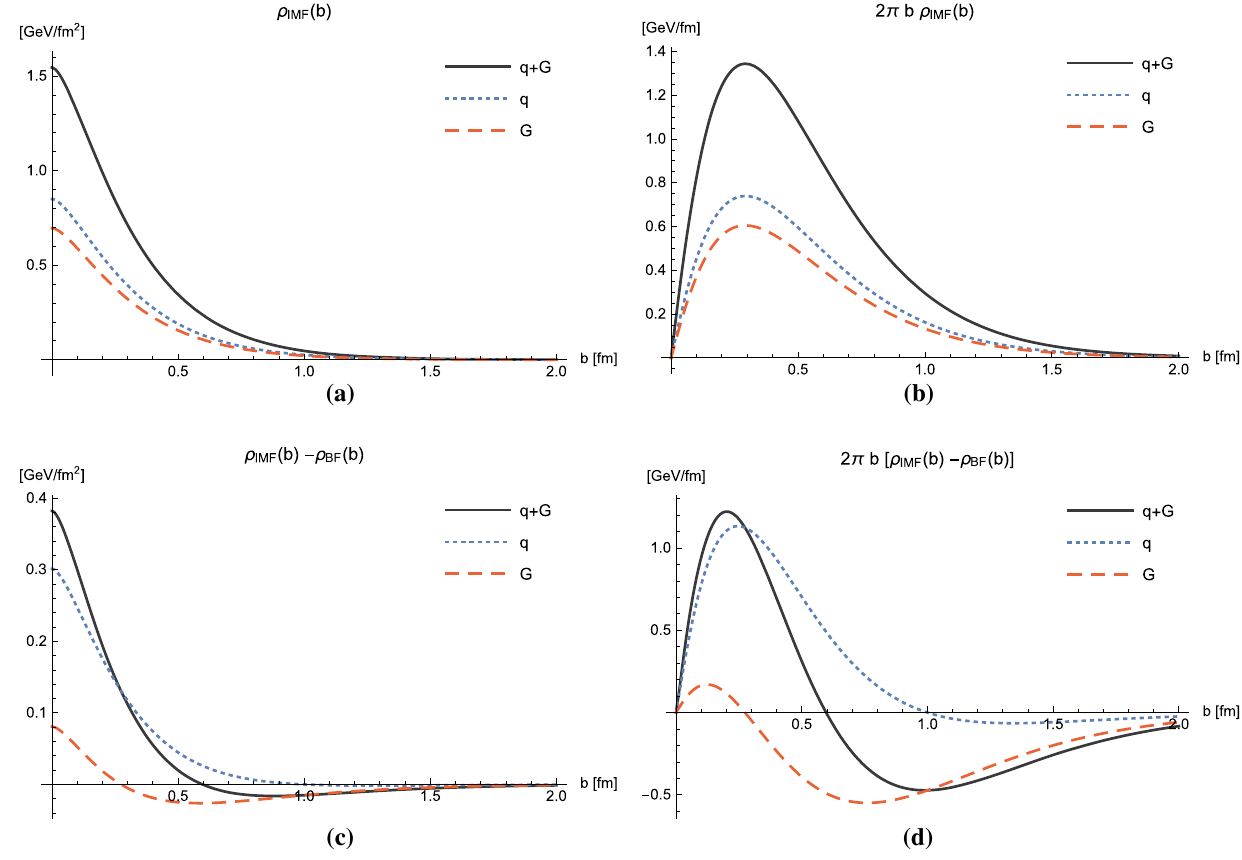
= ρ( b , 0 ) and d 2 π b [ ρ ρ BF model (11) with parameters given in Table 1, see Eqs. (56) or (61), and (83) for the definition in terms of